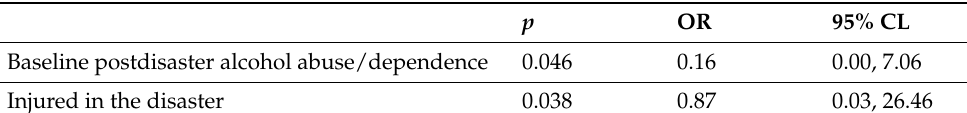
Table 3. Multivariate model predicting number of functioning problems at follow up in Oklahoma City bombing data a